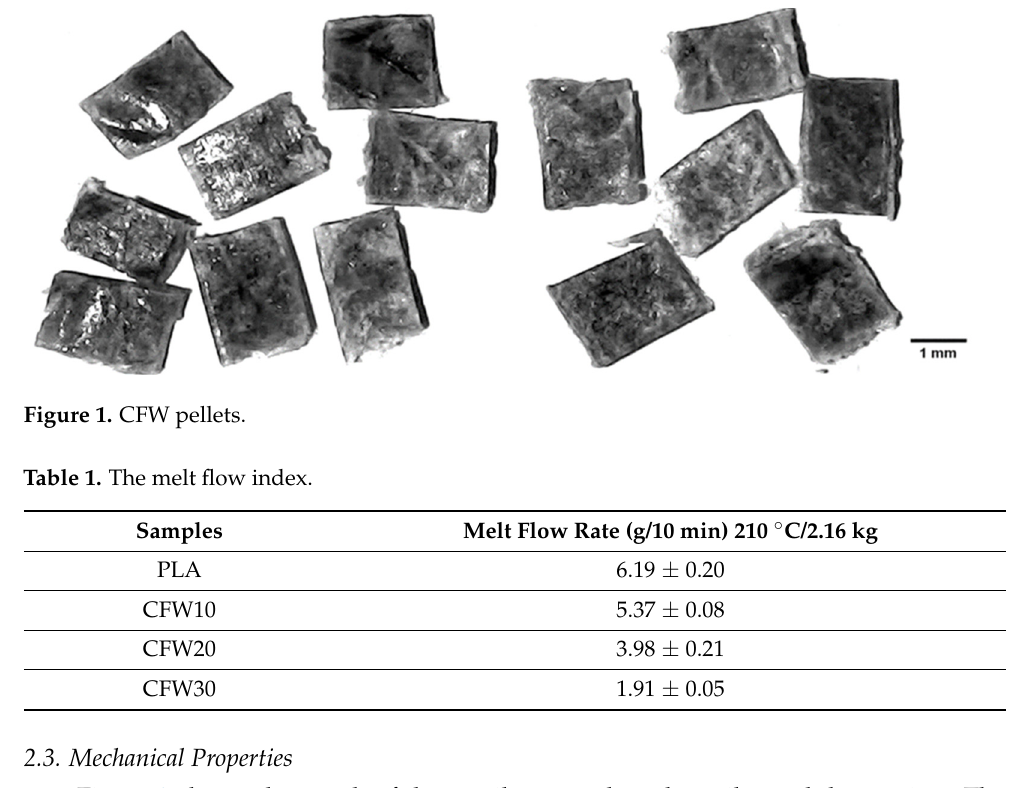
Table 1. The melt flow index.